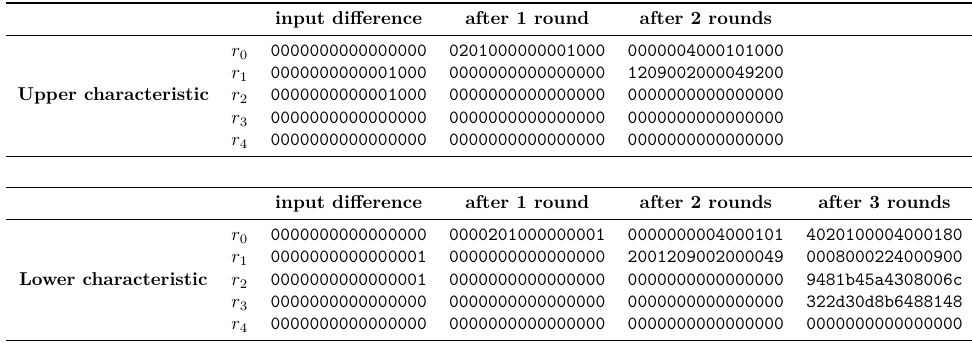
Boomerang characteristic for 5 rounds of the Ascon permutation. The probability of the boomerang characteristic is 2 − 96 but the probability of the rectangle characteristic is 2 − 85 . 57 . The breakdown of the probability (in − log ) for the upper and 2 lower characteristics are [2 , 6] and [2 , 6 , 32] respectively input difference after 1 round after 2 rounds Upper